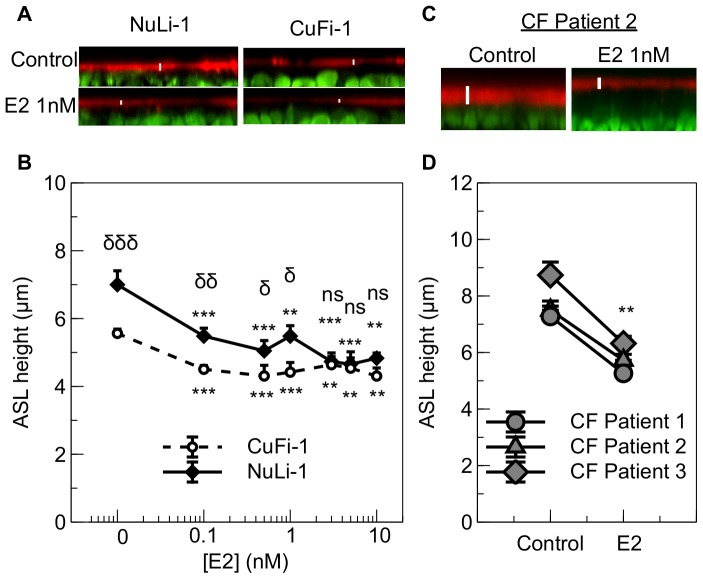
Concentration-dependence of 17β-estradiol effects on ASL height in NuLi-1 and CuFi-1 epithelial monolayers and the effect of 1 nM E2 on ASL height of primary CF bronchial epithelial cells.Epithelial cells were stained with Calcein Green and the ASL stained using dextran conjugated Texas Red™ fluorochrome 24 h before estrogen treatment. Panel A shows representative z-plane sections of NuLi-1 (left) and CuFi-1 (right) cells under basal conditions (top) and after 30 mins treatment with 1 nM E2 (bottom). Mean changes in ASL height in control conditions or following treatment with different concentrations of estrogen are shown in panel B for NuLi-1 (solid line) and CuFi-1 (dashed line) cells (n≥4, Error bars reflect standard error of the mean, ANOVA, ** p<0.01, *** p<0.001, compared to control conditions; δ p<0.05, δδ p<0.01, δδδ p<0.001, difference between NuLi-1 and CuFi-1 cells at the indicated estrogen concentration, ns: non significant). Representative z-plane sections of CF primary bronchial epithelial cells under basal conditions (left) and after 30 mins treatment with 1 nM E2 (right) (panel C) and mean changes in ASL height in primary bronchial epithelial cells of 3 CF female children (panel D) (n = 3, paired t-test, ** p<0.01)